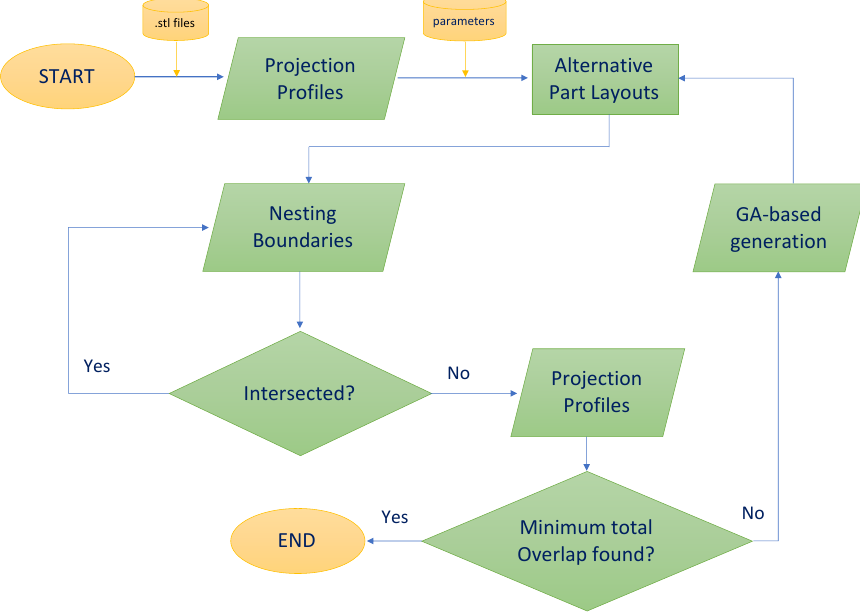
Figure 11. Flowchart of two-dimensional optimization used in